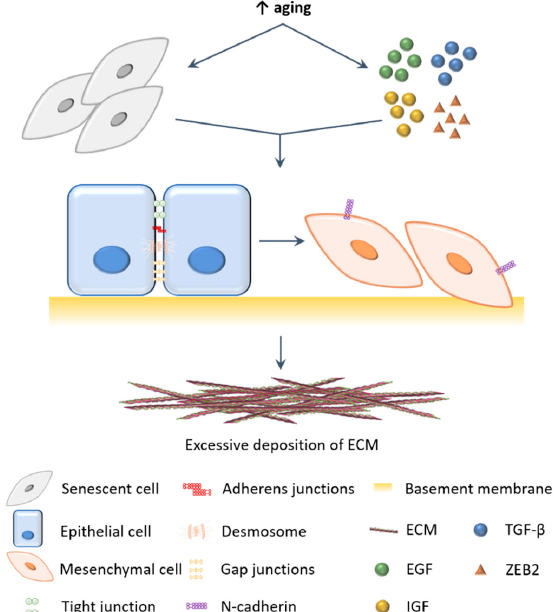
Figure 1. Role of epithelial-mesenchymal transition (EMT) in aging. Pro-EMT signals (eg. transforming growth factor- β (TGF- β ), epidermal growth factor (EGF), insulin-like growth factor (IGF) and transcription factor ZEB2) and senescent fibroblasts with a senescent-associated secretory phenotype (SASP) accumulate in aged tissues, which are responsible for the induction of EMT. Epithelial cells lose their cell–cell junctions and apical-basal polarity. Cells begin to express N-cadherin, acquire front-rear polarity and gain motility, thus transdifferentiating into mesenchymal cells, such as fibroblasts. Fibroblasts produce extracellular matrix (ECM) components and are the main cellular mediators of fibrosis. When these cells accumulate (e.g., due to EMT), excessive fibrotic tissue is formed, affecting the function of vital organs. This figure was produced using Servier Medical Art. Table 1. Expression of epithelial and mesenchymal markers in fibrotic organs. Organ Characteristics Reference